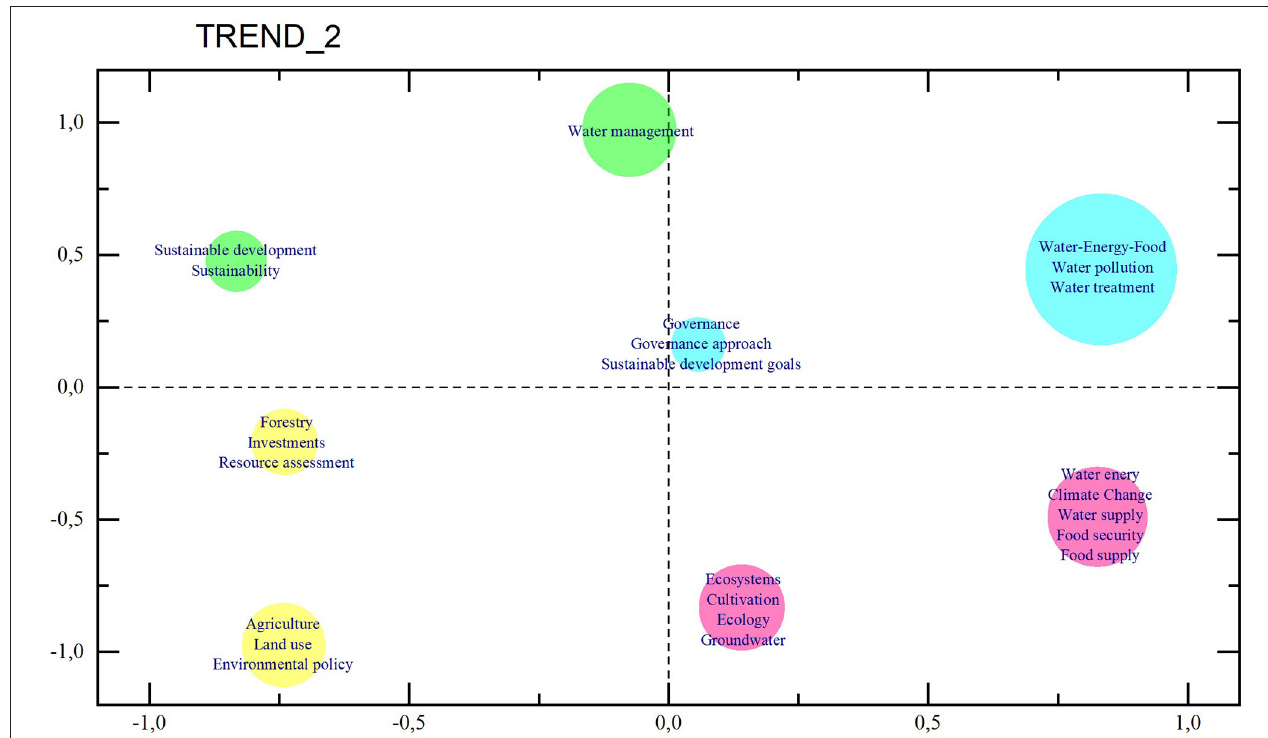
FIGURE 5 | Trend 2 key topics on WEF nexus research in the period